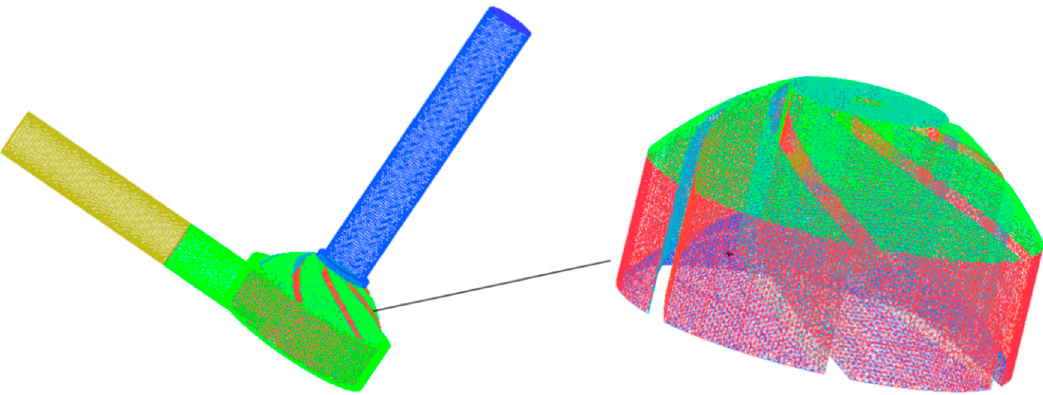
Figure 3. Mesh of the centrifugal blood pump.